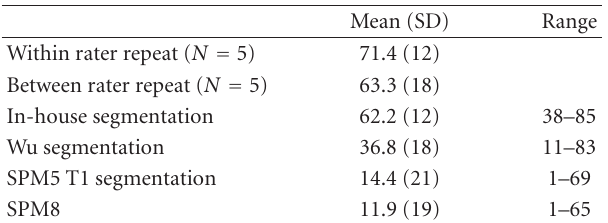
Table 2: Percent overlap of segmentation methods against manual